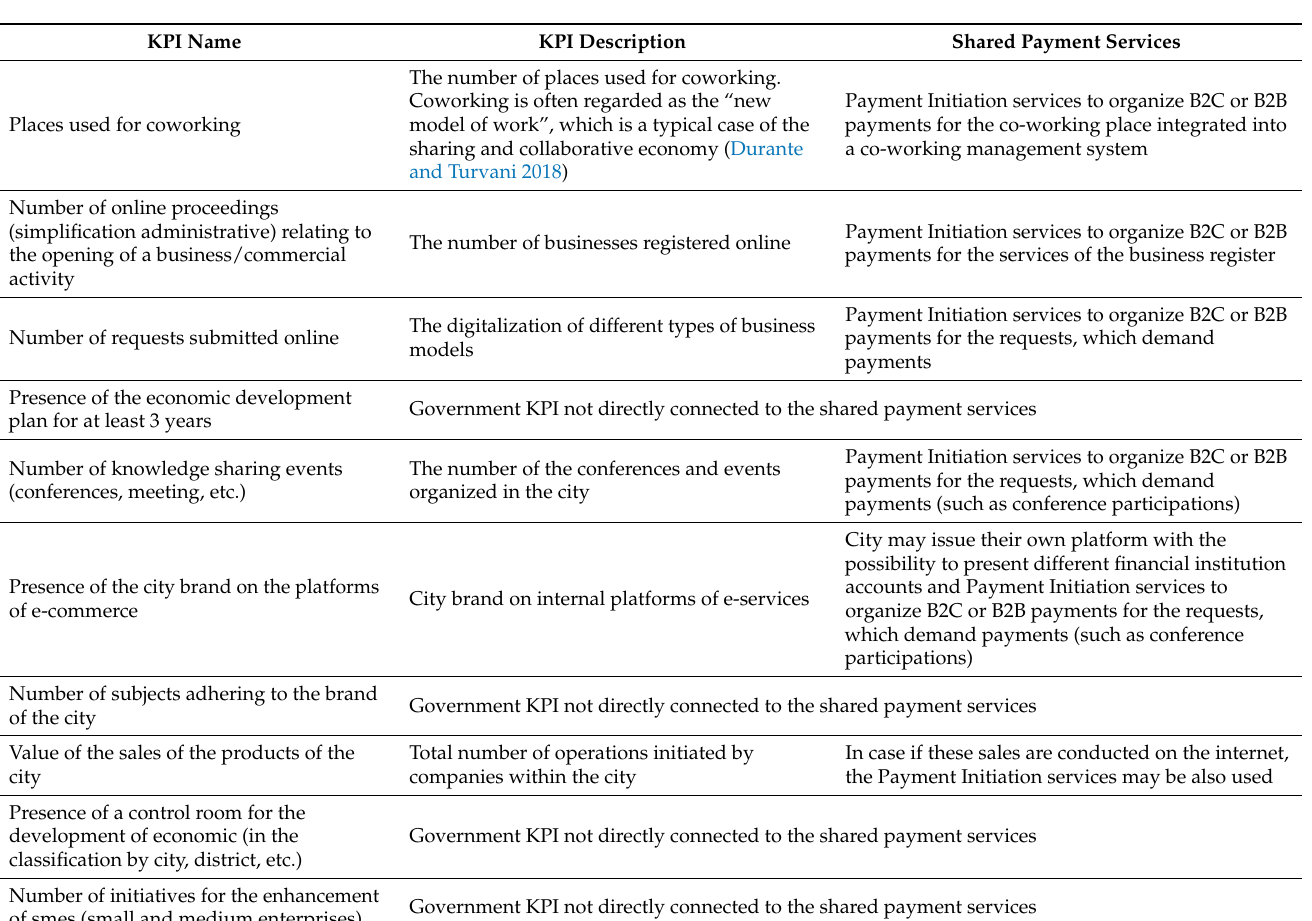
Table 1. KPIs of Rome smart city. Source: generated by the authors; the KPIs were taken from O’Leary et al.